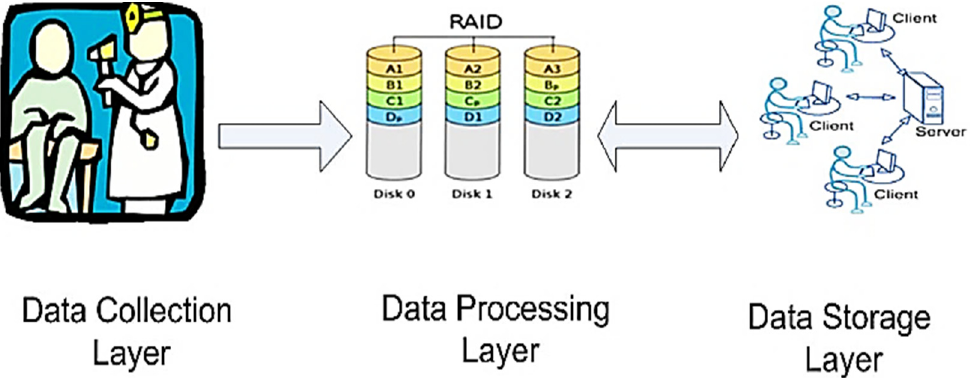
Figure 24. Mobile health (m-health) system architecture, proposed in [75] (Reprinted with permission from ref. [75]. Copyright 2021 IEEE).